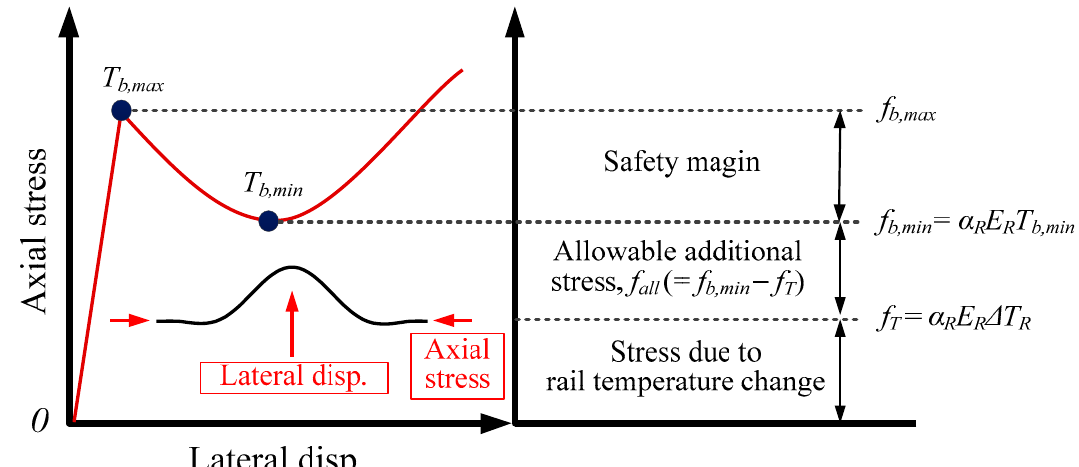
Figure 4. Concept of additional axial stress (compression) calculation.